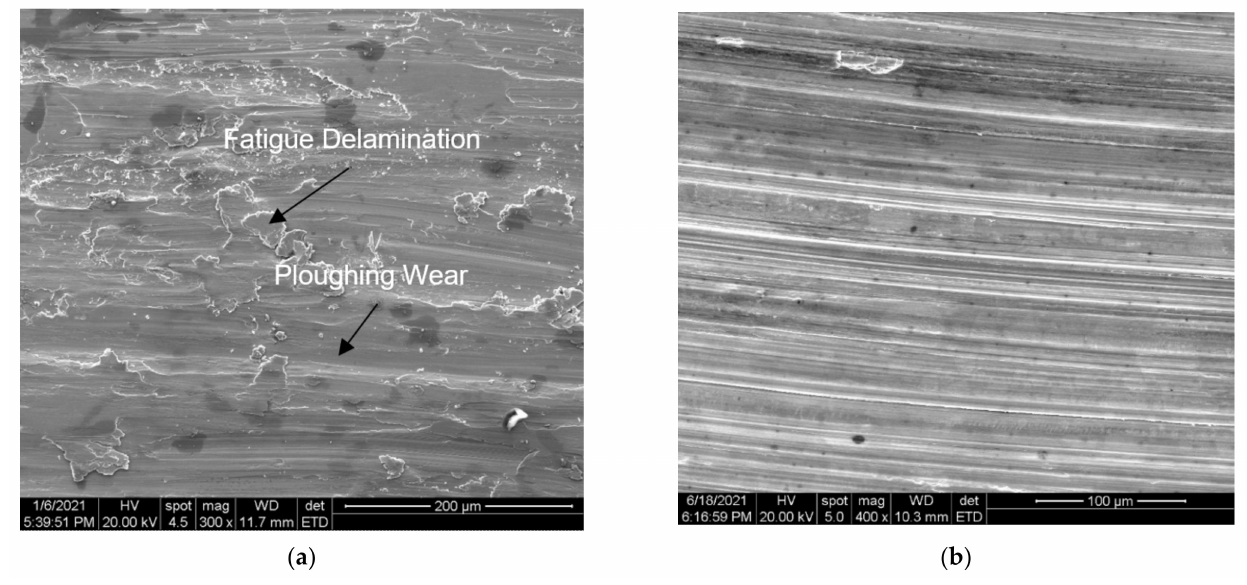
Figure 7. The wear scars of the tin bronze substrate with and without the running-in coatings after tribological testing: ( a ) the tin bronze substrate; ( b ) the tin bronze with the running-in coatings of specimen 2. Table 7. The elemental composition of the running-in coating surface after tribological testing.